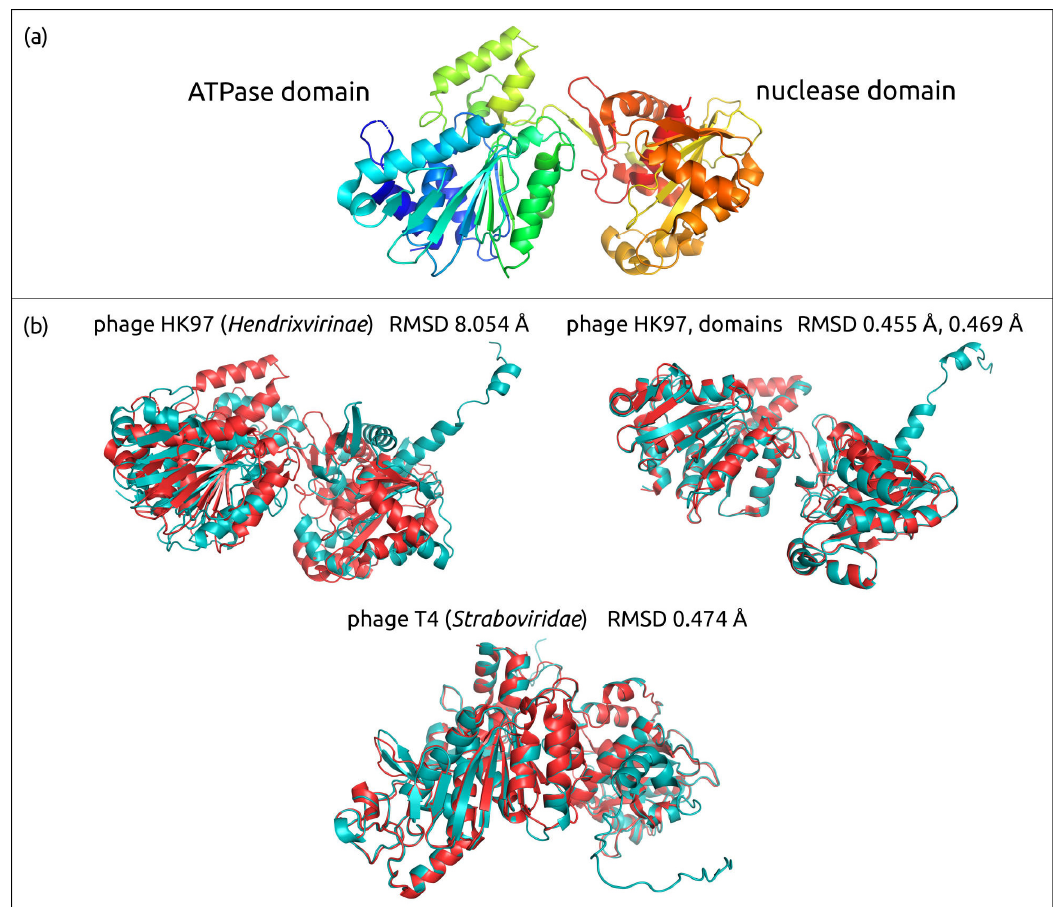
Figure 4. Structural models of the product of the whole genes encoding for the ATPase subunit of terminase in the genomes of representative viruses (Table 1), obtained with AlphaFold. The N-ter- minus is labelled with a blue circle and the C-terminus is labelled with a yellow circle. Other pre- dicted terminase structures are shown in Supplementary Figure S3.